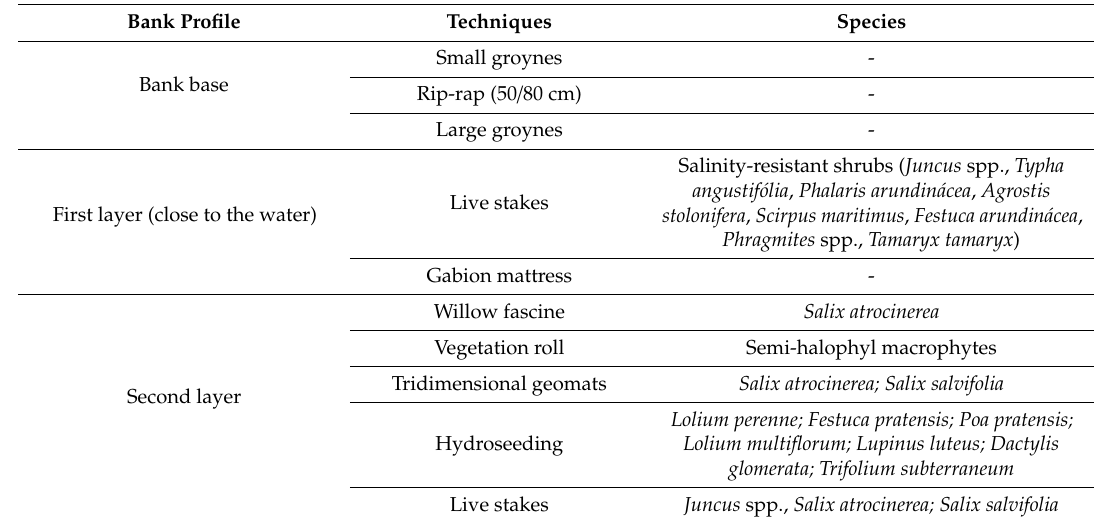
Table 1. Description of the planned techniques involved in each layer for the Cardielos